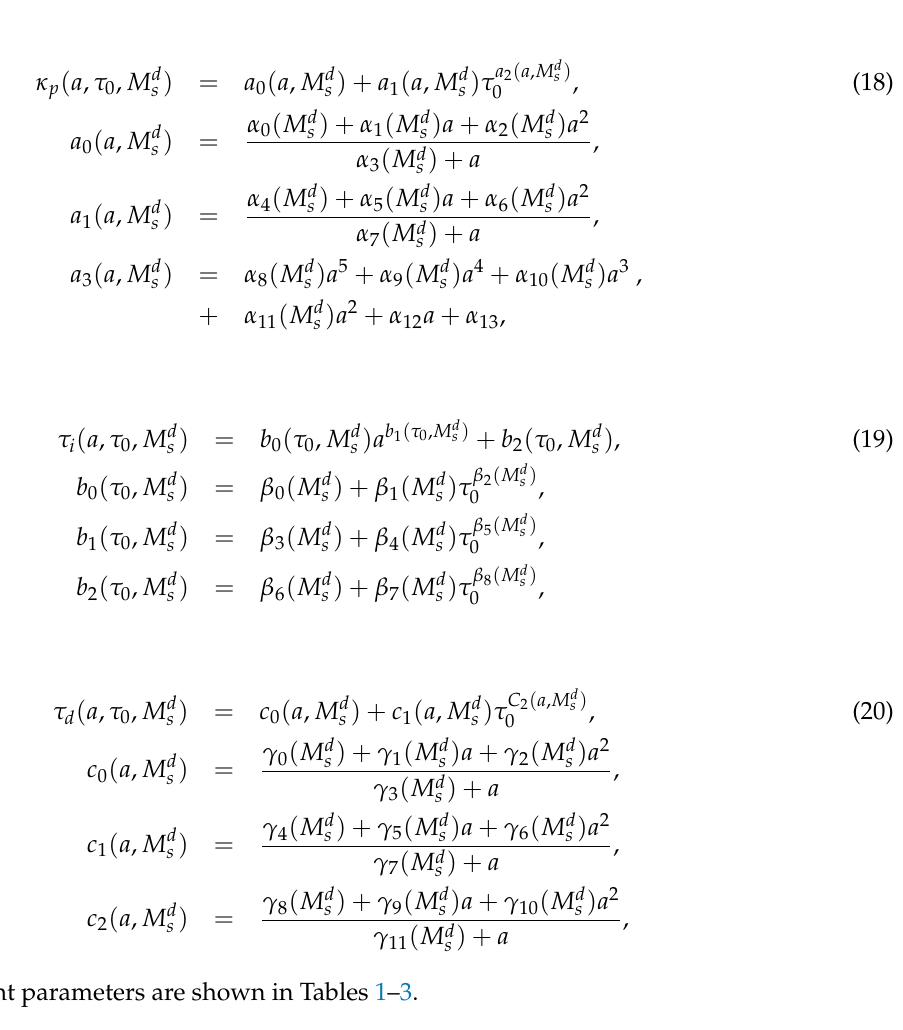
Table 1. Coefficient parameters α i ( M d s ) for κ p in the servo